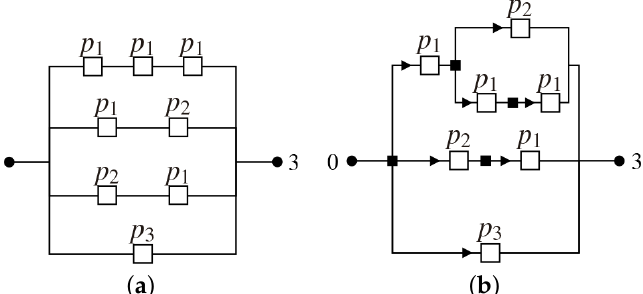
Figure 2. Alternative configurations of the opportunistic network model presented in Figure